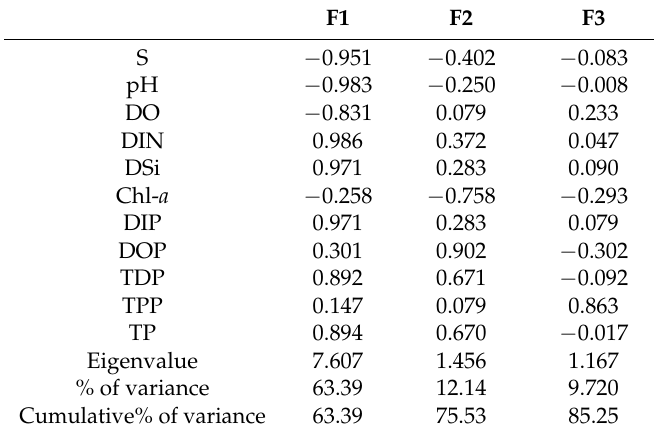
Table 6. Rotated varimax factor analysis of the various P species and environmental parameters in the water column of the Dafengjiang River